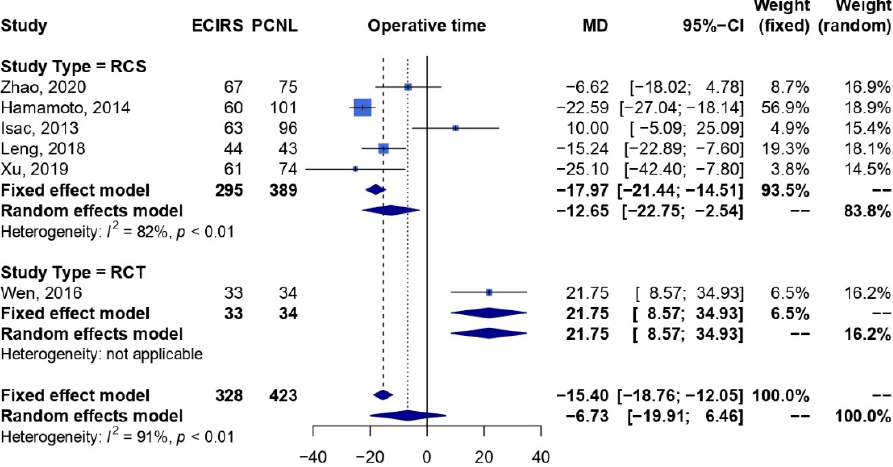
Figure A17. Subgroup analysis of outcome regarding operative time. (RCS: [18,19,21–23]; RCT: